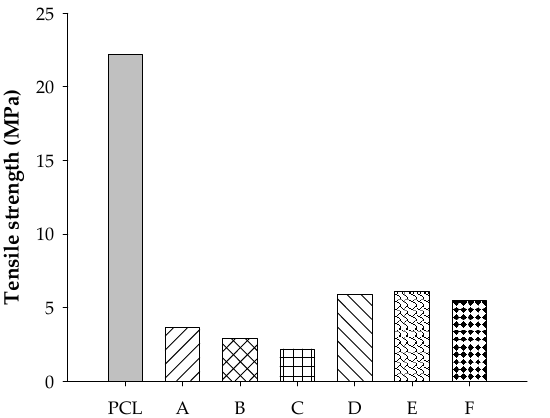
Figure 5. Hardness of PCL, A = STR5L / PCL at 40 / 60, B = STR5L / PCL at 50 / 50, C = STR5L / PCL at 60 / 40, D = ENR-50 / PCL at 40 / 60, E = ENR-50 / PCL at 50 / 50, and F = ENR-50 / PCL at 60 / 40.